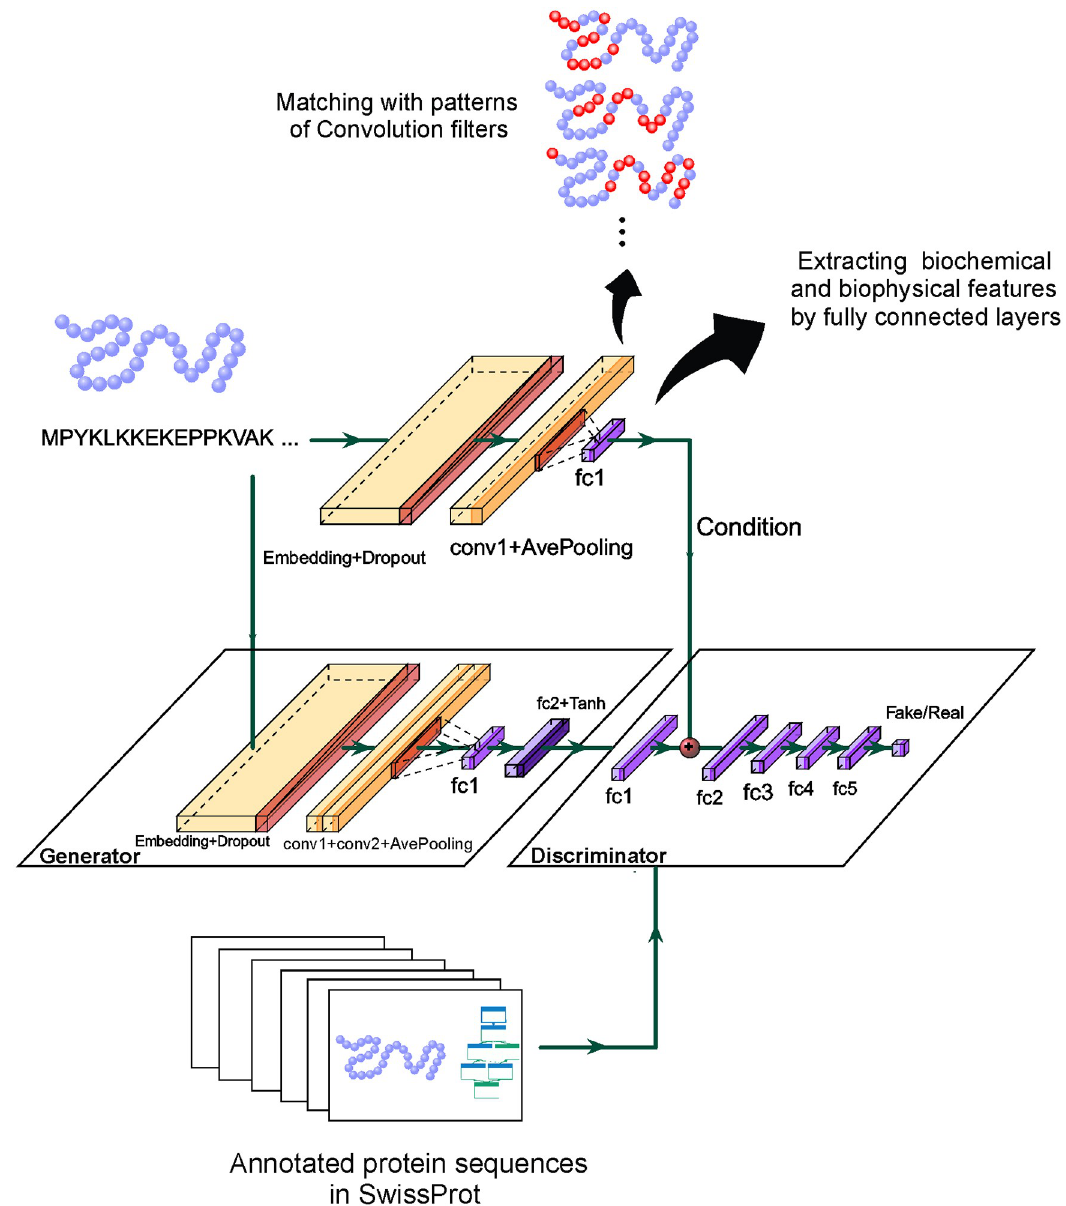
Fig 1. The proposed method for protein function prediction. Given the input sequence of amino acids, the generator has an embedding as its first layer which converts one-hot vectors to more compact representations. Then, one dimensional convolution filters are employed to explore meaningful sequential patterns. Then biochemical and biophysical features of the input are extracted from obtained activation maps. These features are used to predict GO annotations by the last fully connected layer. A discriminator judges about the validity of the obtained annotation for this sequence by observing pairs of protein sequences and their experimentally approved annotations in SwissProt. By observing proteins which are annotated by a common set of GO terms, discriminator could extract correlations between GO